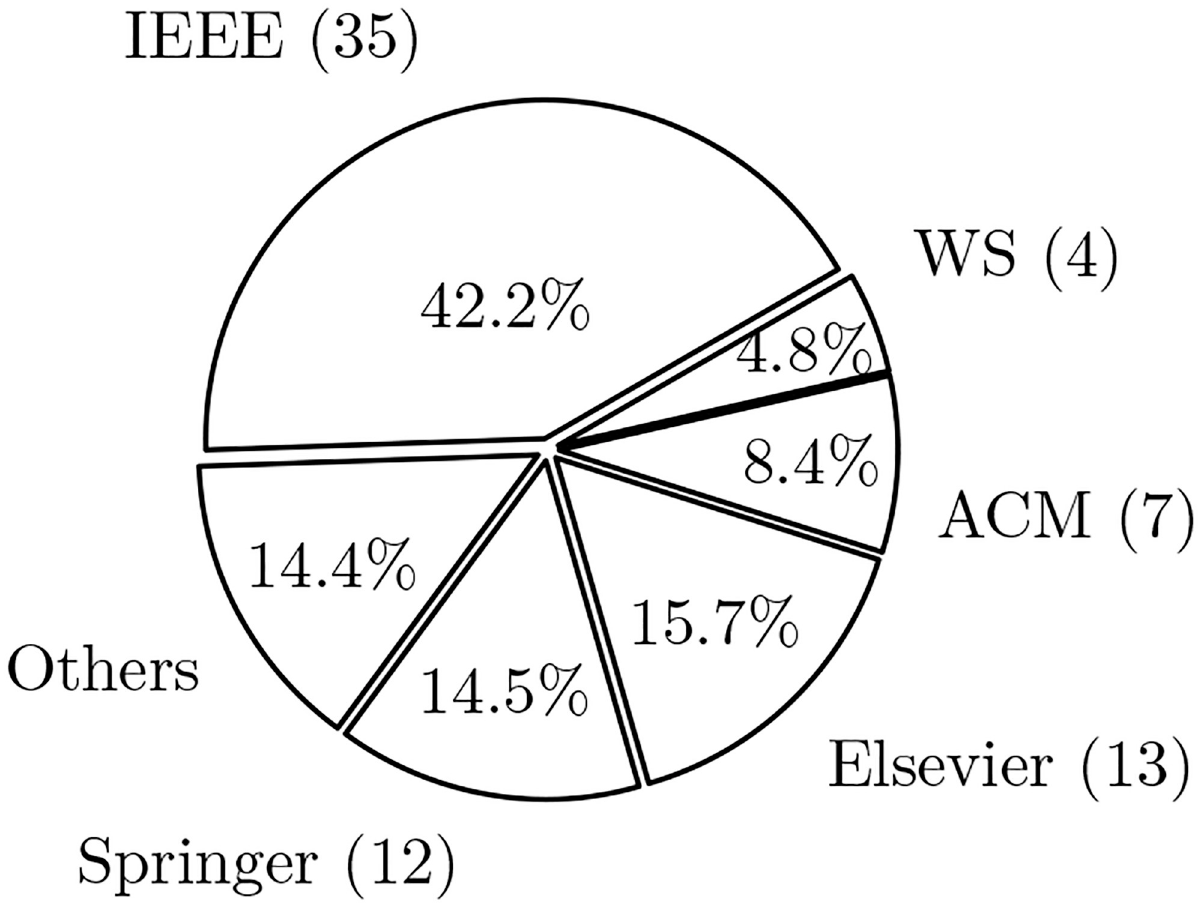
Fig 4. Papers distribution by publishers. The pie chart shows the distribution (in percentages) of the papers we considered in our reading log by publishers. Acronyms used: IEEE—IEEE Xplore, WS—World Scientific.